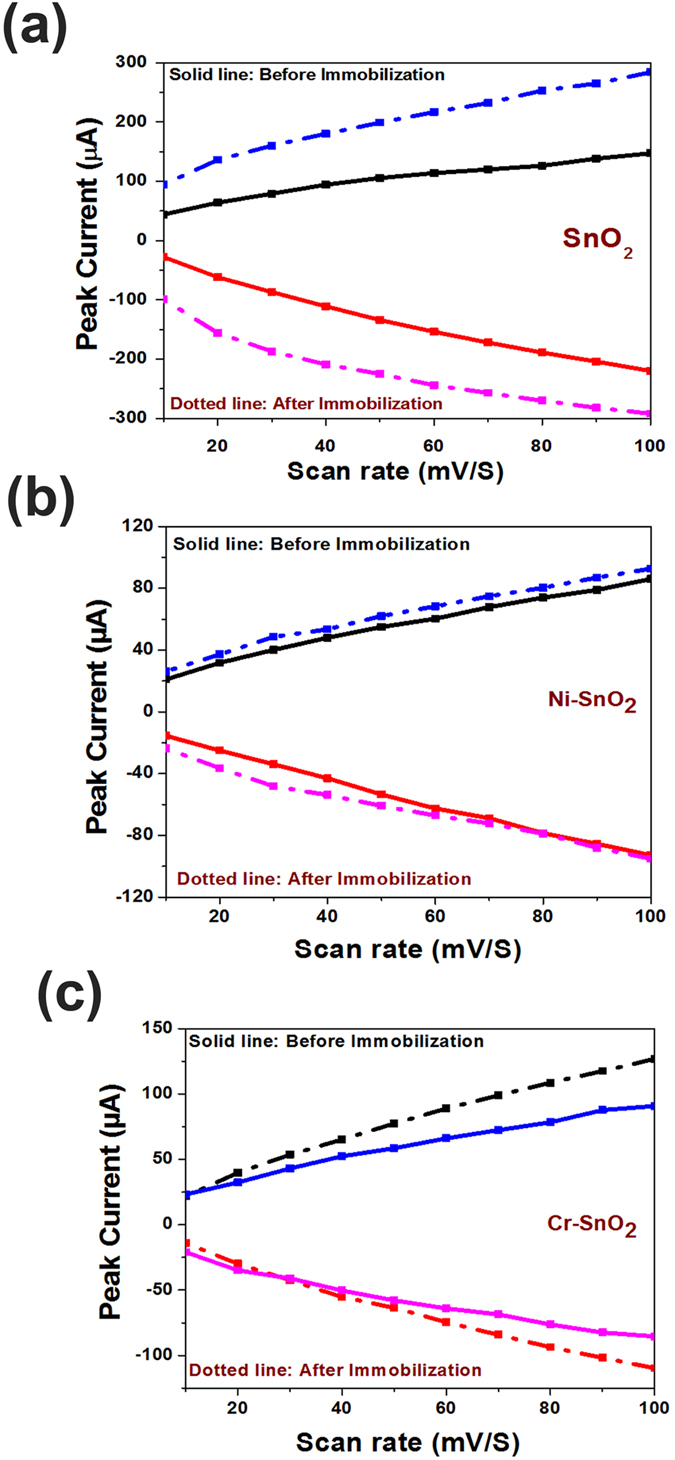
Redox peak current as a function of Scan rate variation for (a) SnO2, (b) Ni-SnO2 and (c) Cr-SnO2.